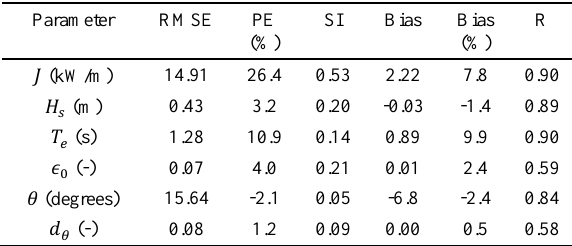
Fig. 9. Comparison of observed and simulated six IEC resource parameters for year 2017 at NDBC buoy 46075 in the Alaska Coast region. From top to bottom: omnidirectional wave power, significant wave height, energy period, spectral width, direction of maximum directionally resolved wave power, and directionality coefficient. Buoy location is shown in Fig. 4. The improved accuracy of these 32-year regional hindcasts compared to the 30-year NOAA WWIII hindcast has been demonstrated [7-9]; particularly for large wave heights , and rare events, e.g., those occurring at a 50-year recurrence interval [12]. There error statistics for the predicted six IEC parameters at the three example buoy stations are shown in Table 2 to Table 4, respectively. T ABLE